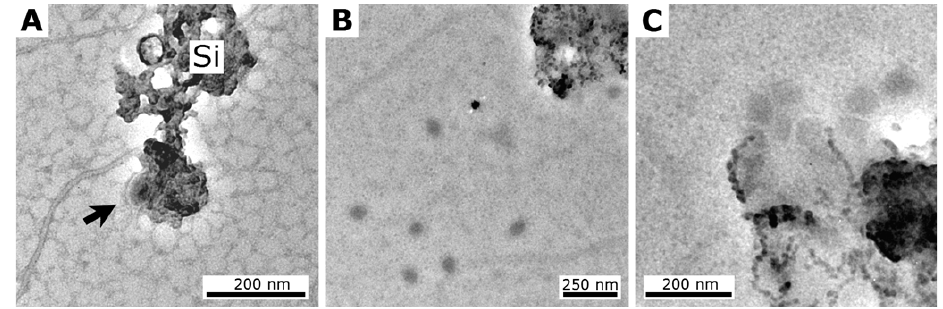
Fig. 4. TEM micrographs showing progressive steps of the experimental fossilisation of PAV1 at a ∼ 320ppmSi silica concentration. (A) 1day, PAV1 particle (arrow) attached to the silica precipitate (Si). (B) 60days, unstained grid, numerous PAV1 particles near the silica precipitate. (C) 60days, unstained grid, aggregate of PAV1 particles trapped in a finely grained silica precipitate. All TEM micrographs were made at 200kV on grids negatively stained with uranyl acetate, unless otherwise